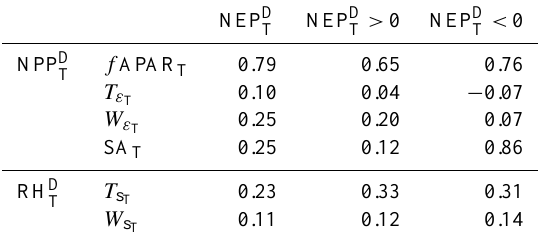
Table 7. Partial correlations between the trends in NPP D (NPP D and R D (RH D ) and trends in its drivers: f APAR, temperature ( T ε ) H T and water availability ( W ε ) effects on ε ∗ ( f APAR T , T ε respectively) for NPP D ; and substrate availability (SA), tempera- T ture ( T s ) and soil moisture ( W s ) effects on microbial decomposition (SA T , T s and W s , respectively) for RH D T T